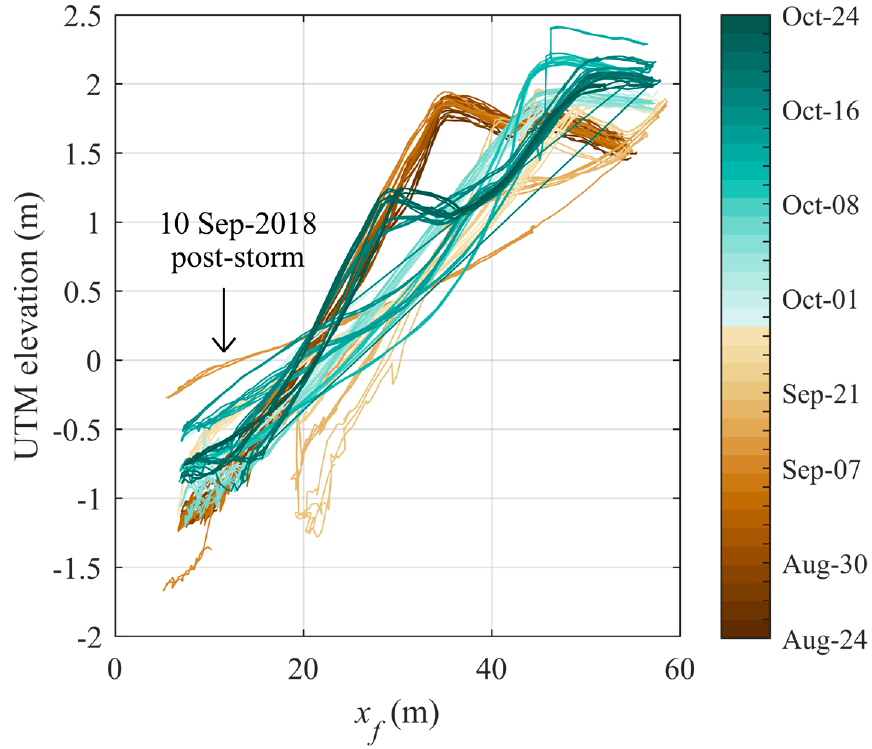
Figure 14. Beach profile evolution over the experiment duration. The profiles are the transect surveyed on the left (north) side of the frame looking seaward ( y f approximately − 5 m).